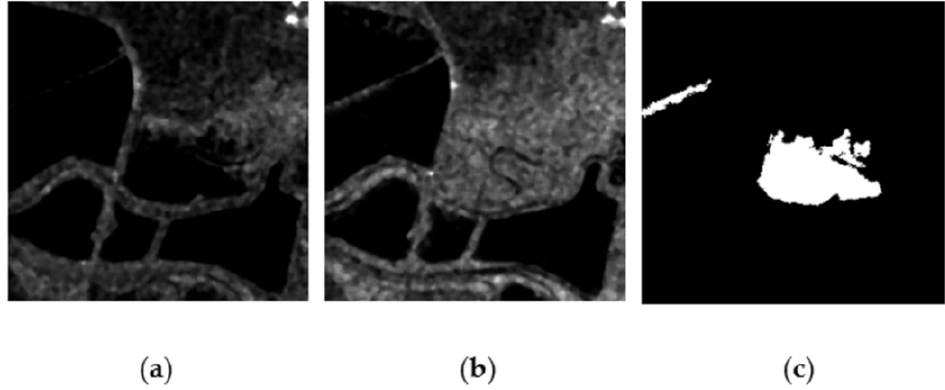
Figure 13. San Francisco dataset with a 25-m resolution. ( a ) Image acquired in August 2003. ( b ) Image acquired in May 2004. ( c ) Ground truth.